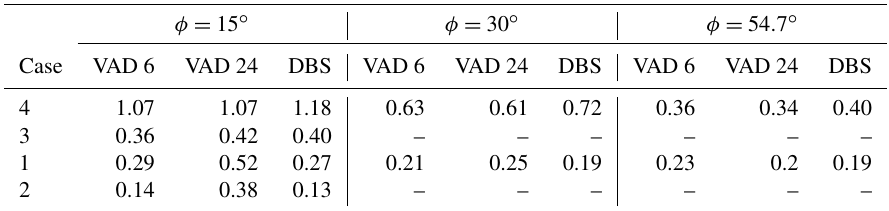
Table 2. Overview of results for lidar measurements in different meteorological conditions averaged over a period of 10min. Shown are lidar errors (RMSD in ms − 1 over the extent of the respective boundary layer height) for different zenith angle configurations and scan schemes. Case numbers are according to Table 1. The cases are sorted by atmospheric stability, beginning with the least stable case. Values for case 4 and case 1 are mean values of the ensemble. φ = 15 ◦ φ = 30 ◦ φ = 54 . 7